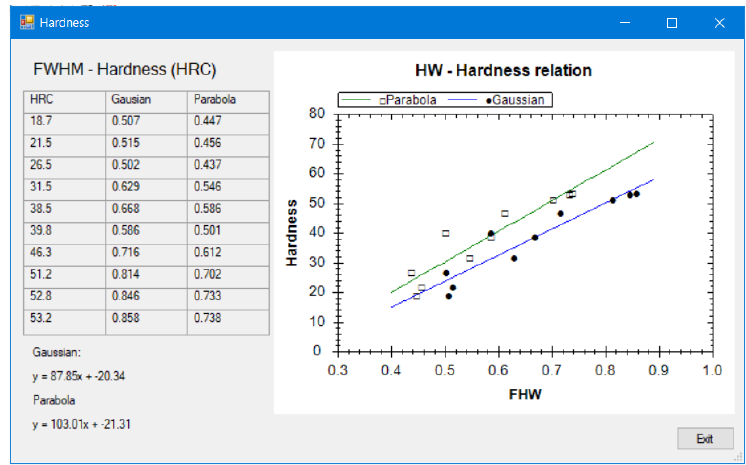
Figure 10. Dialog box for determining the hardness of quenched S50C.